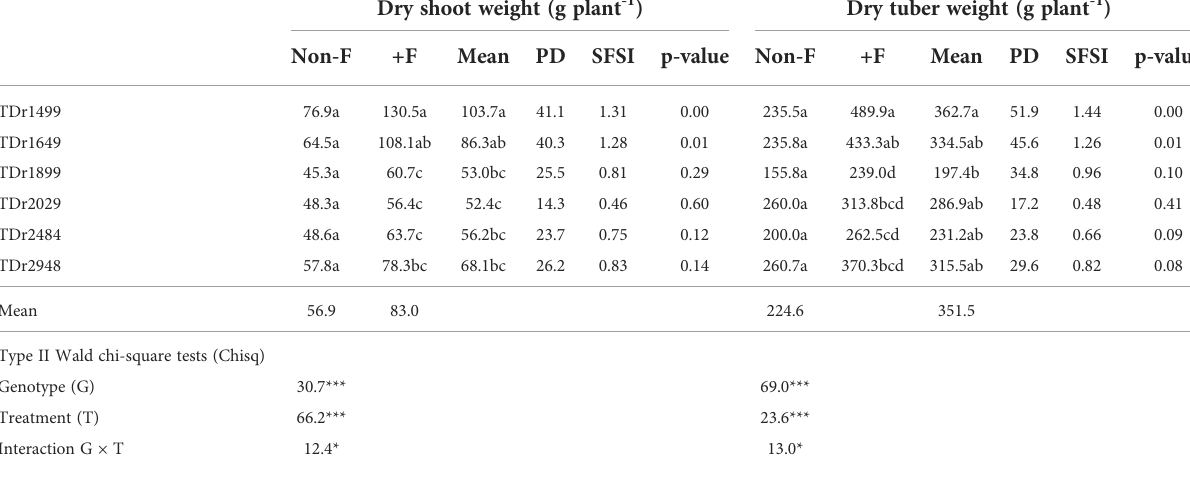
TABLE 3 Effect of genotype and fertilizer treatment on the shoot and tuber weight in six white Guinea yam ( Dioscorea rotundata ) genotypes In the 2018 trial.